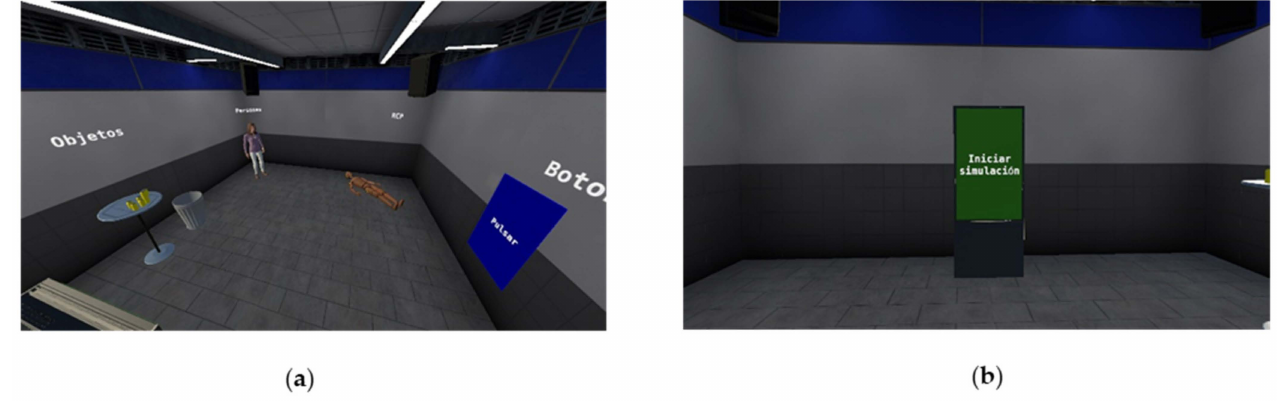
Figure 5. ( a ) Adaptation scene where the user can test the simulator mechanics. ( b ) User interface which triggers the start of the simulation once the user is ready.